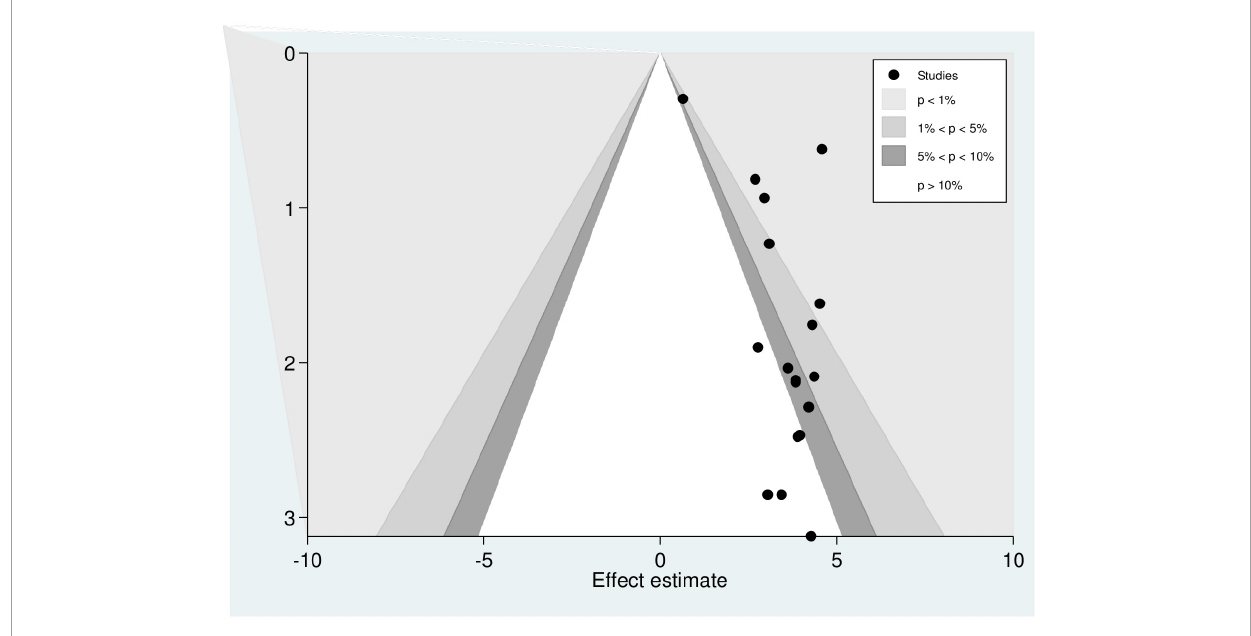
FIGURE7 Counter-enhanced funnel plot showing that funnel plot asymmetry is due to the presence of publication bias.